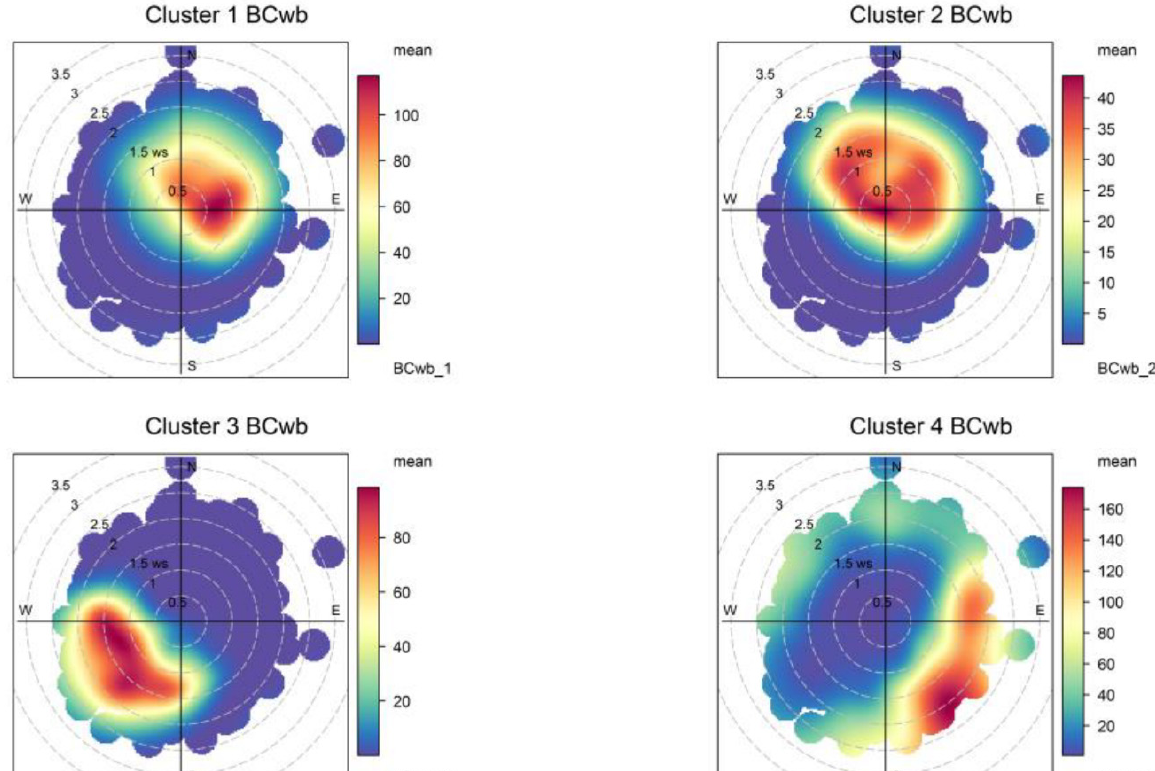
Figure 8. Bivariate plots for the four fuzzy clusters' contributions to BC wb .